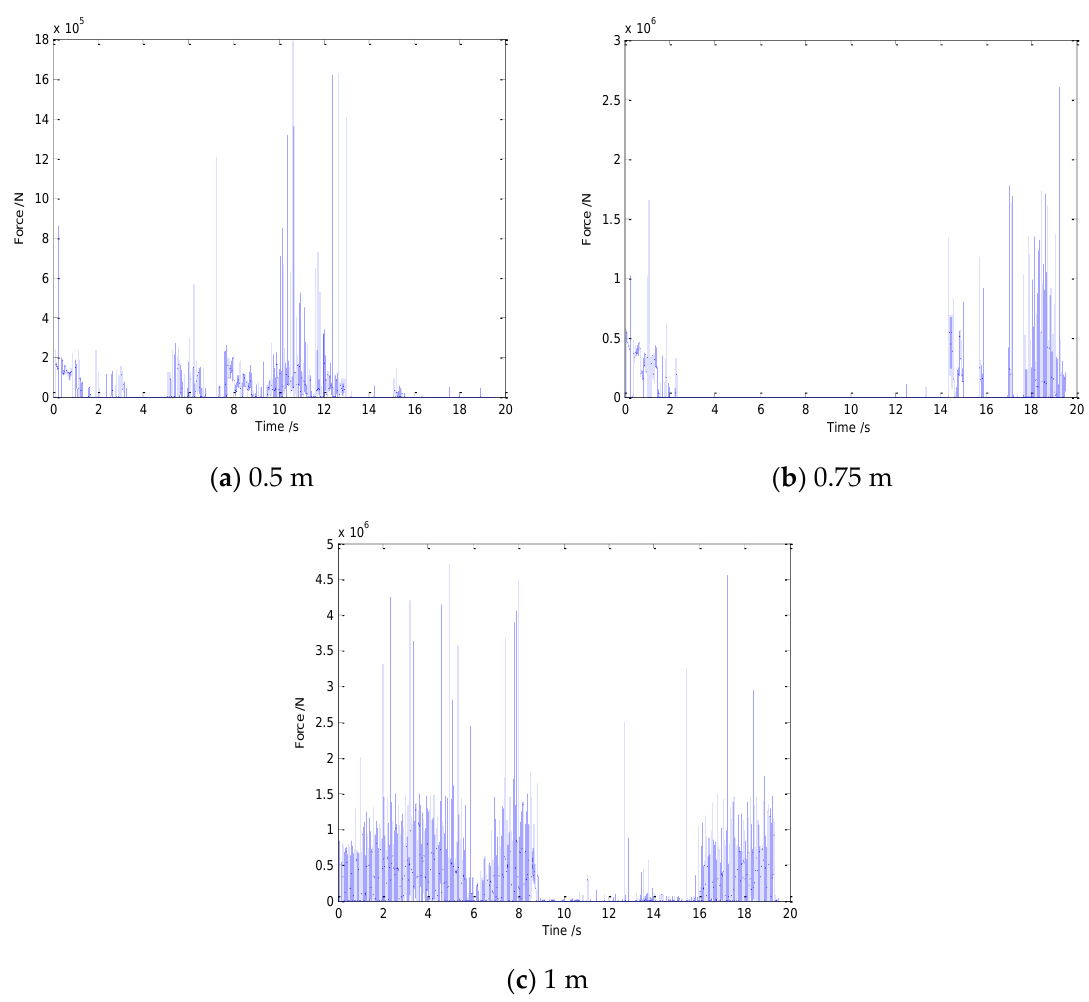
Figure 15. Time history of ice load with different ice thicknesses.